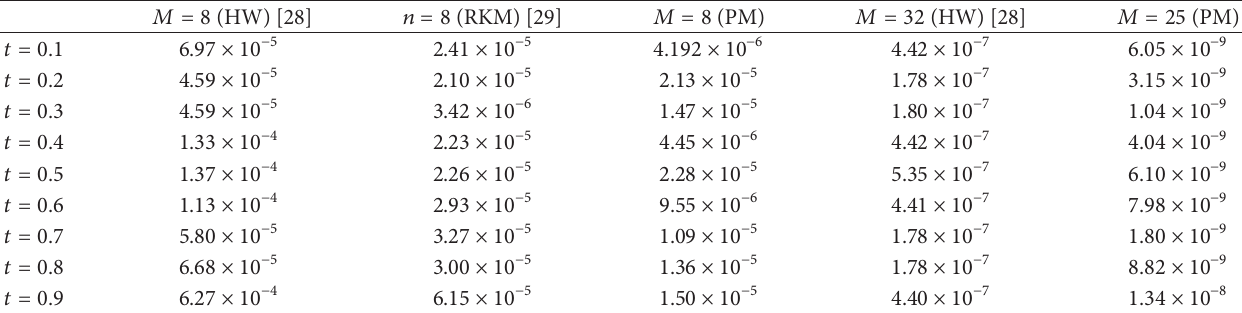
Table 1: Comparison of absolute error of Example 1 obtained with the proposed method and its comparison with Haar wavelets [28] and RKM